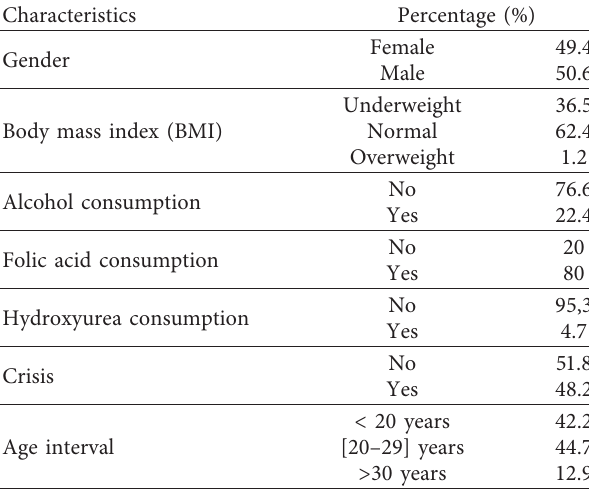
Table 1: Characteristics of the population of the study.